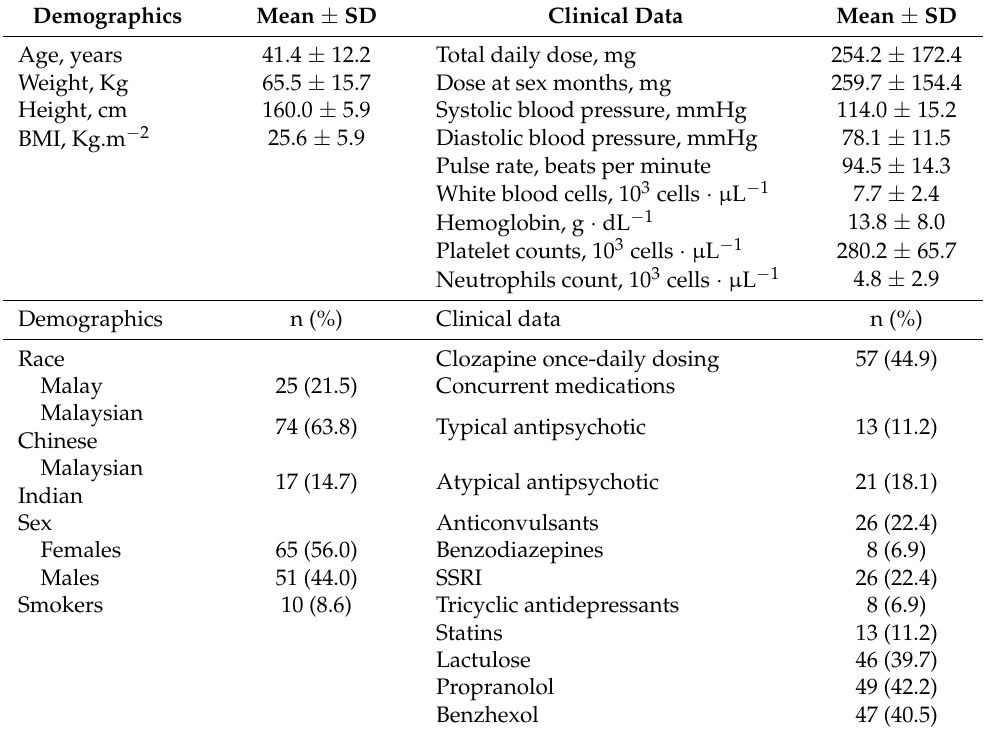
Table 1. Demographic and clinical characteristics of Malaysian patients with schizophrenia spectrum disorders on clozapine (n =